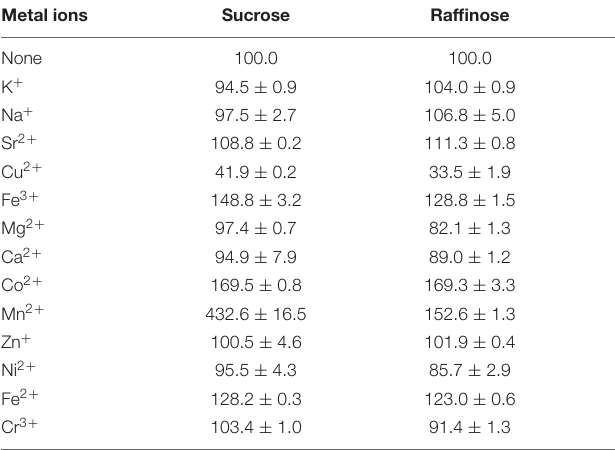
TABLE 2 | Effects of cations on InvDz13 activity. Metal ions